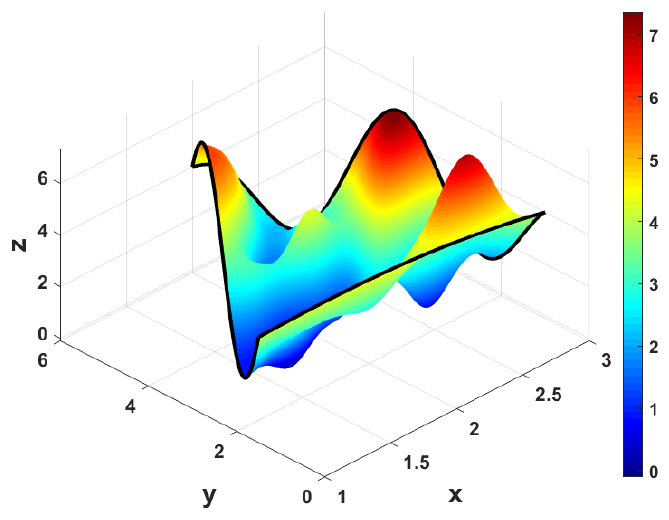
√ x exp x ) sin ( 5 y ) 2